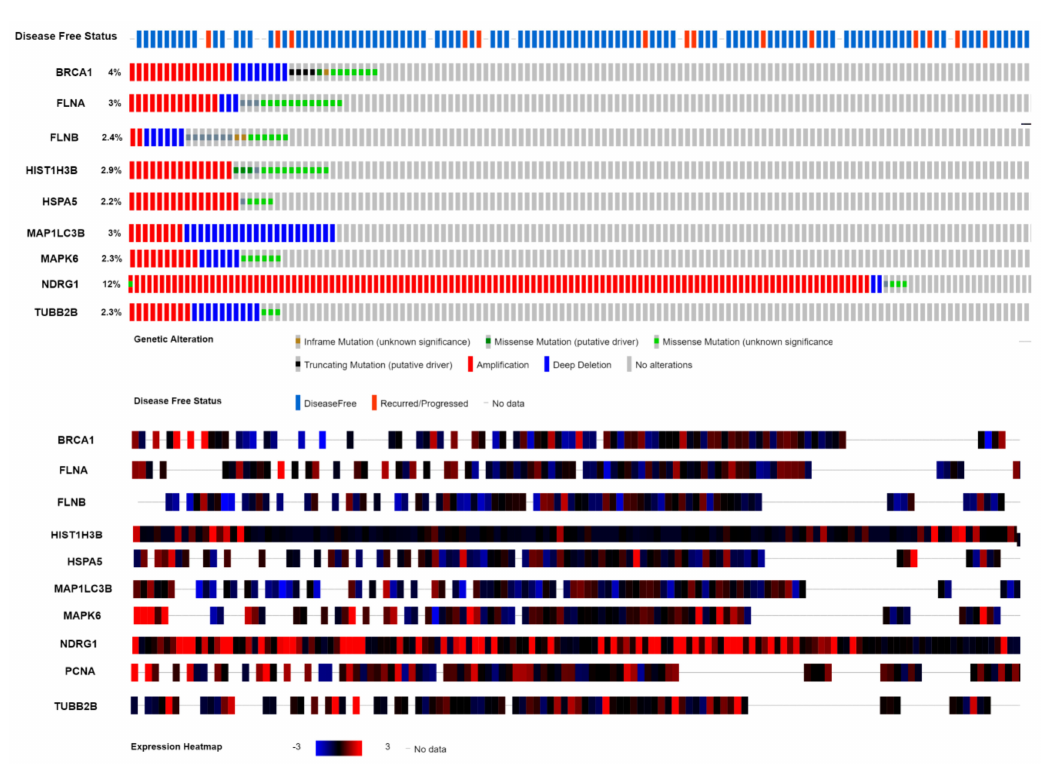
Figure 22. A visual summary, which displays genetic alteration of the ten hub genes in The Cancer Genome Atlas-Breast cancer (TCGA-BRCA)